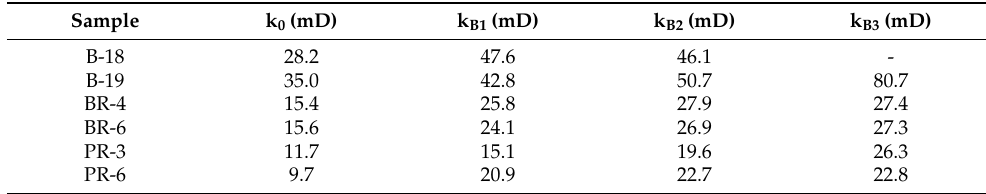
Table 4. Brine permeabilities for Berea, Bandera Brown, and Parker plugs flooded with two times diluted Thisted brine with EDTA (2D*TB EDTA